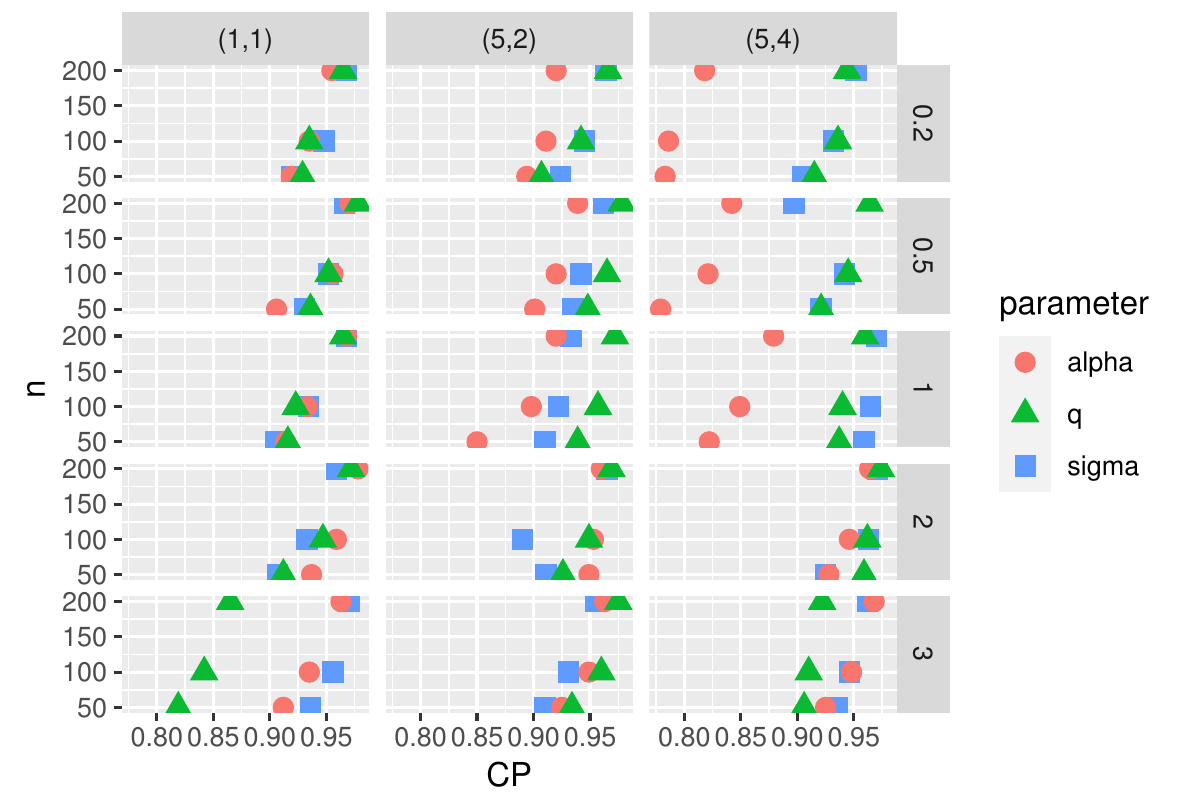
Figure 6. Empirical CP for the ACI ( n = 50,100,200) in the SPHN model ( σ = 1, α = 1, q ) = SHN ( 1, q ) , ( σ = 5, α = 2, q ) , ( σ = 5, α = 4, q ) with q = (red point), q (green triangle), and σ (blue square).